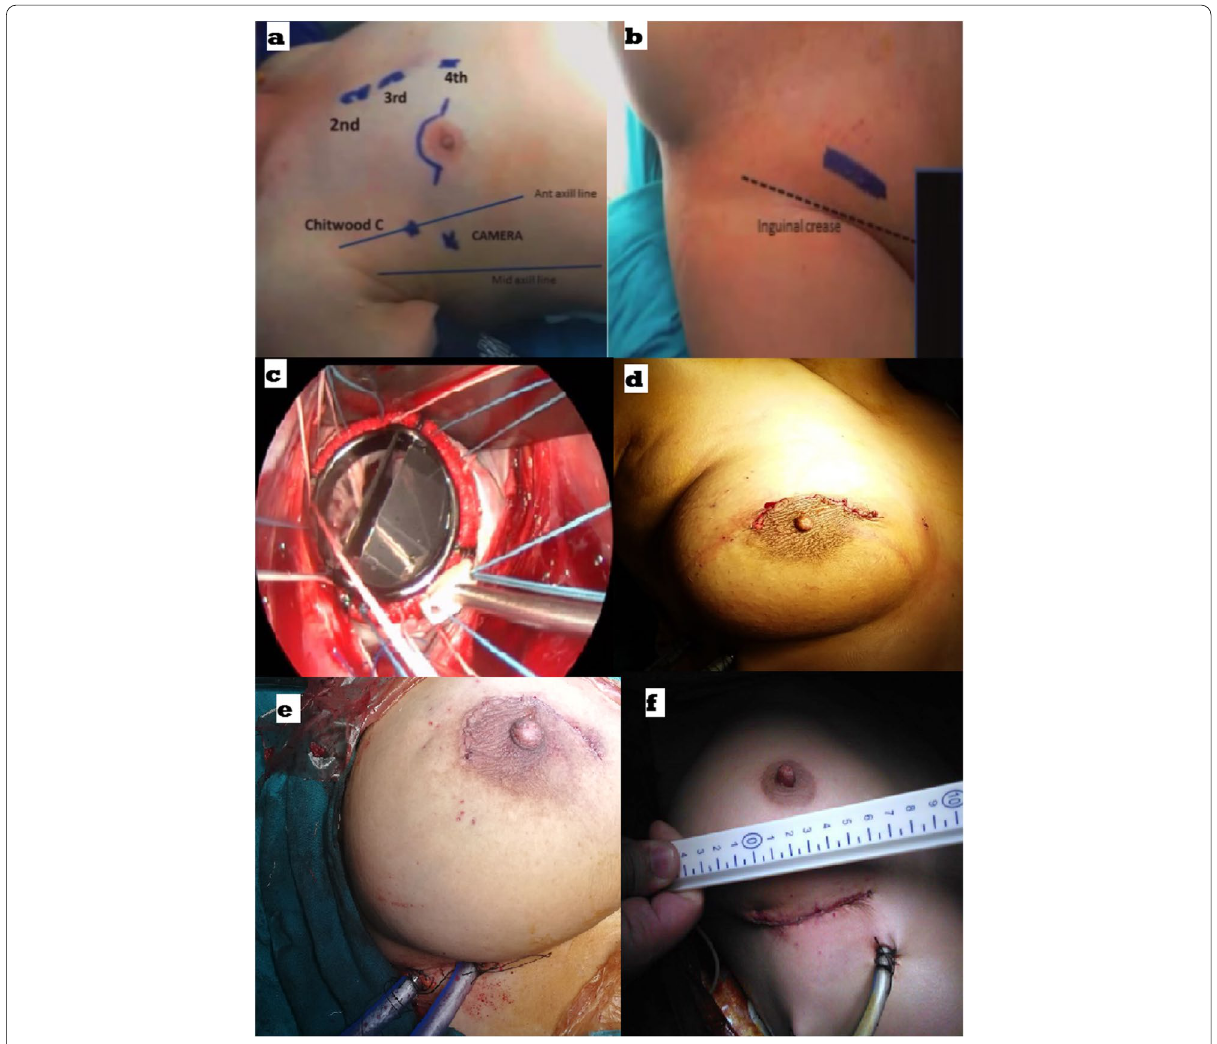
Fig. 2 a Skin demarcation for important landmark points during minimally invasive procedure. A point to the 4th intercostal space in the parasternal line for the left atrial retractor; a point in the anterior axillary line at the level of the 3rd space for Chitwood clamp; a point in the 4th intercostal space in the anterior axillary line for the 30° telescope. b Skin demarcation for groin cannulation. c Video-assisted mitral valve replacement (MVR) with tying the valve sutures using the knot pusher. d Incision for periareolar minimally invasive (PAMI) technique in a woman. e PAMI Incision in a woman with morbid obesity. f Incision for inframammary